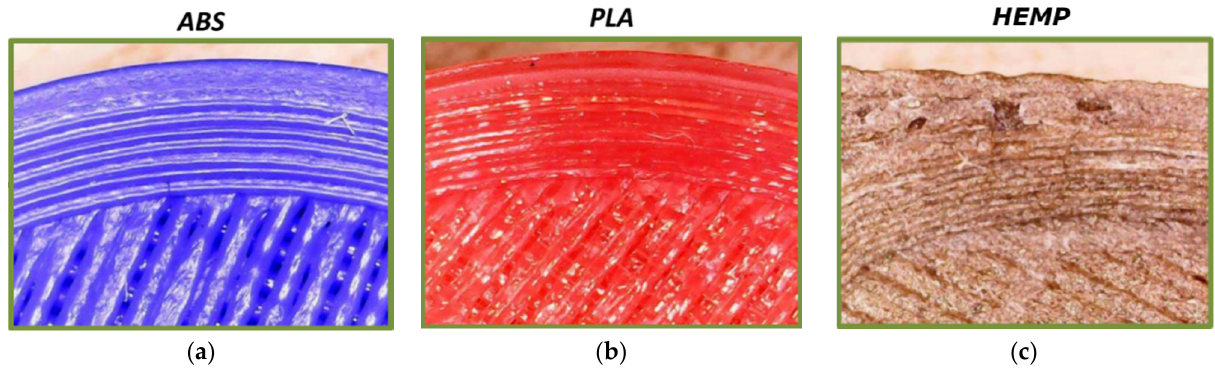
Figure 4. Surface finish compared to traditional materials: ( a ) Acrilonitrile-butadiene-stirene—ABS, ( b ) Polylactic acid—PLA, and ( c ) Polylactic acid filled with 20% hemp—HEMP.